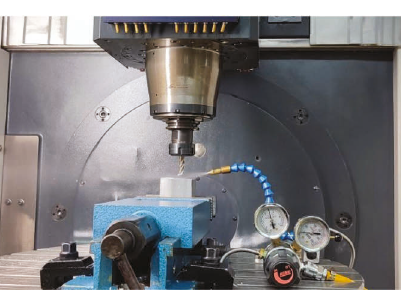
Figure 2: Experiment setup. Table 3: The information of the experiment.